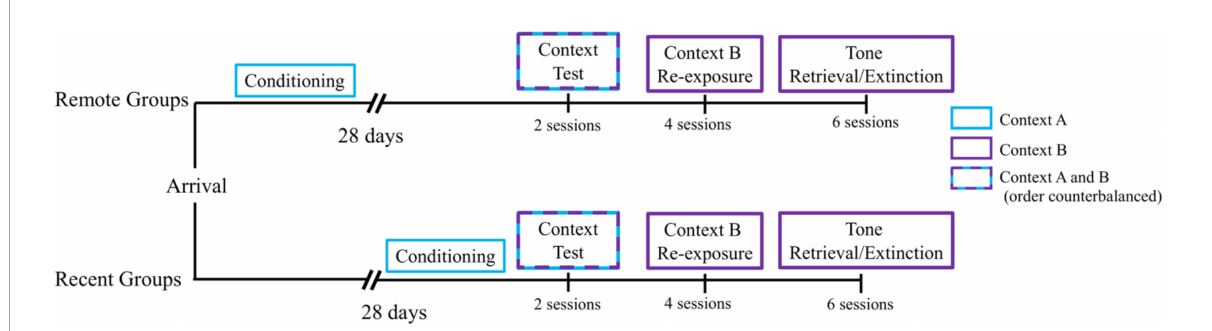
FIGURE1 Experimental timeline. All groups received a single session of auditory fear conditioning in Context A, followed by a 28-day retention interval (Remote Groups) or a 1-day retention interval (Recent Groups) before being tested for context fear retrieval in Contexts A and B (order counterbalanced). On the subsequent 2 days, all groups received 2 daily sessions of Context B Re-exposure, for a total of 4 sessions. Next, all groups received 3 daily sessions of tone retrieval/extinction in Context B for 2 days, for a total of 6 sessions.